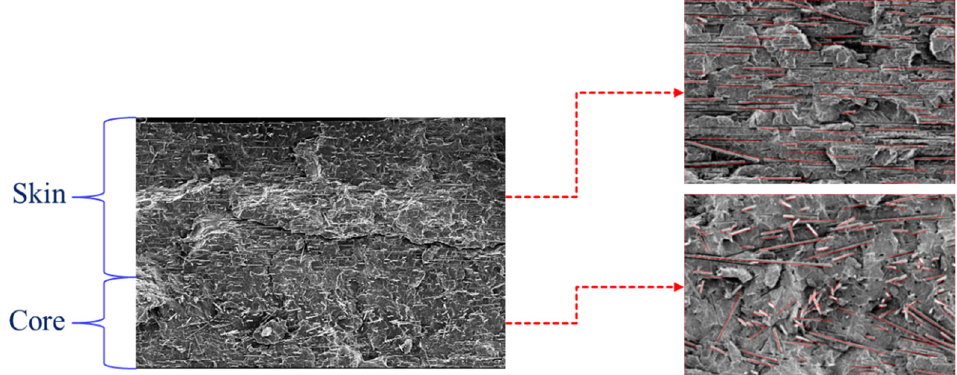
Figure 3. Scanning electron microscopy (SEM) image for evaluating the fiber orientation level (FOL) of the sample. The magnification is ×100.